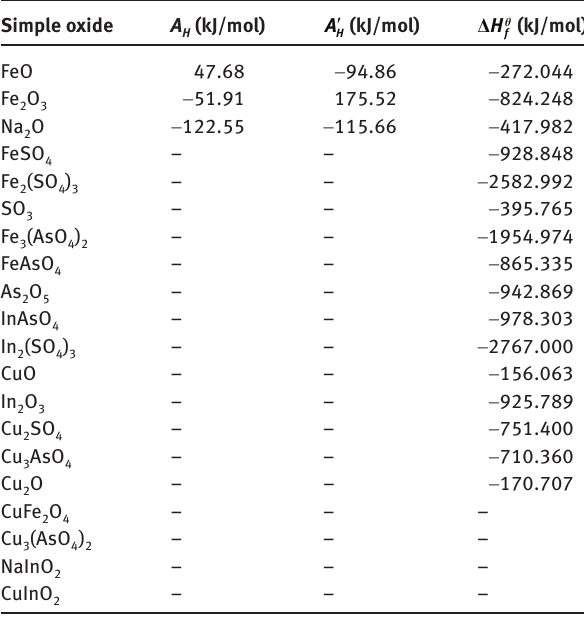
Table 2: A S , ′ S A and θ m S of oxides at 298.15 K